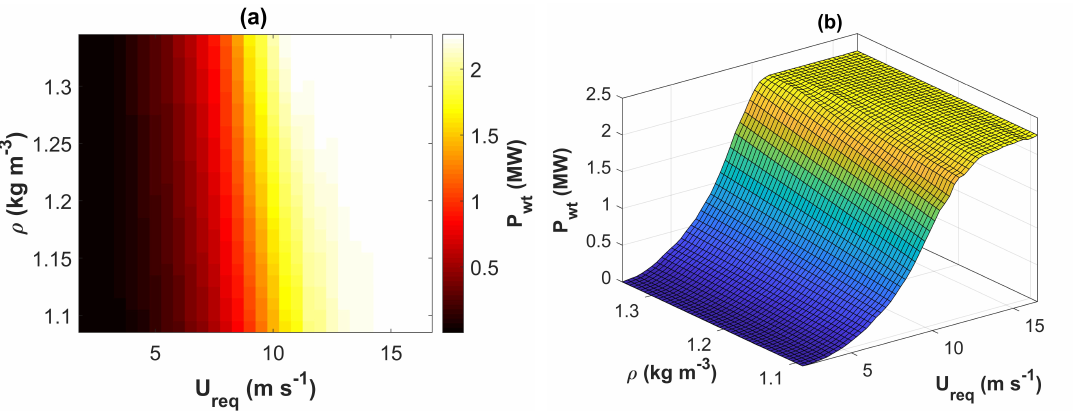
Figure 2. ( a ) Two-dimensional binning of wind power in terms of rotor equivalent wind speed and density and ( b ) the resulting power